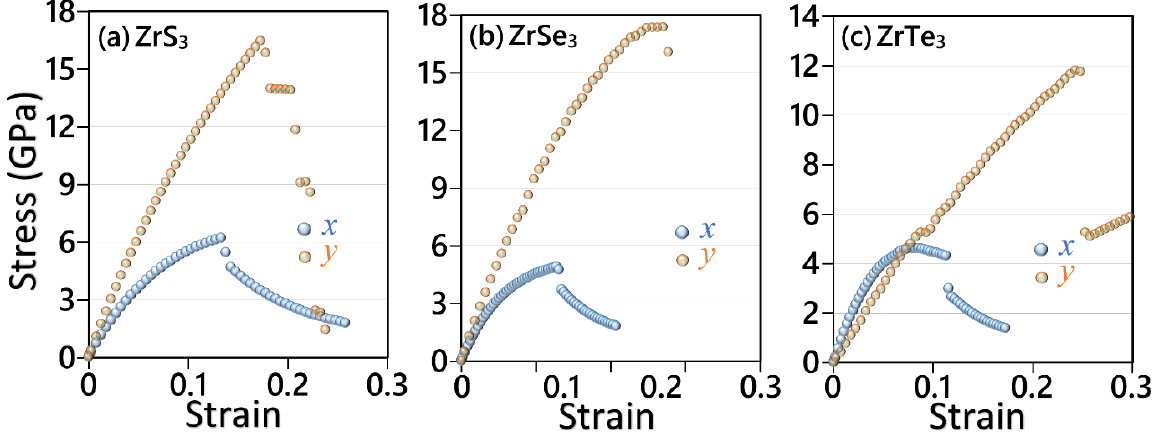
Figure 6. True uniaxial stress–strain relations of the ( a ) ZrS 3 , ( b ) ZrSe 3 , and ( c ) ZrTe 3 monolayers elongated along the y and x directions.